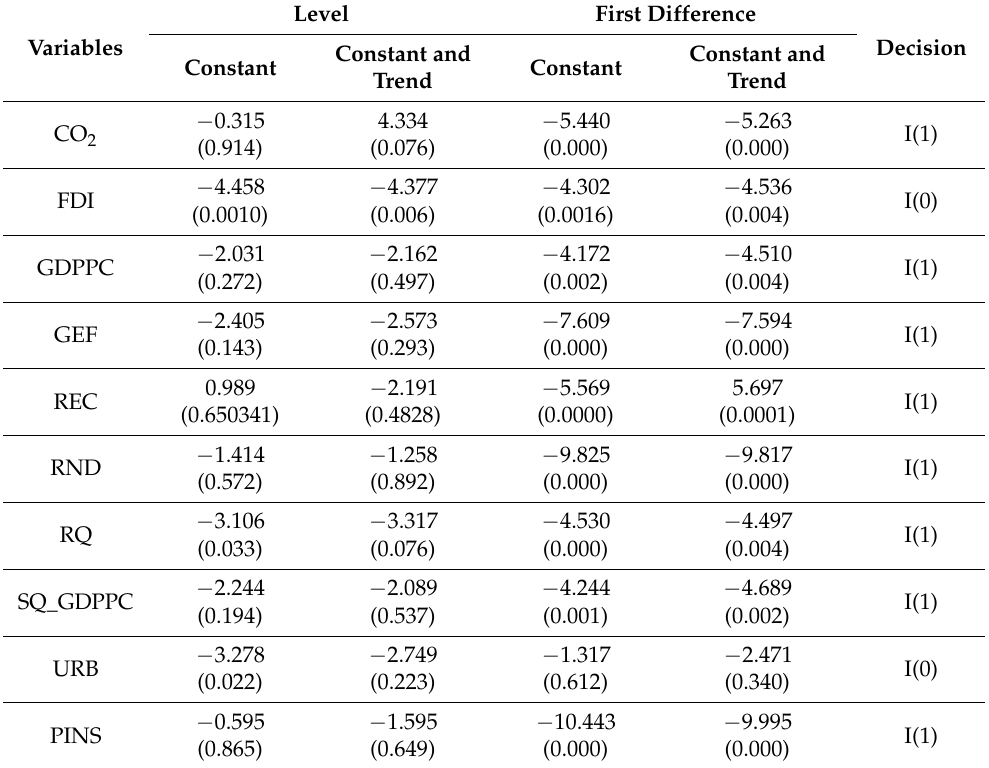
Table 4. ADF Unit Root